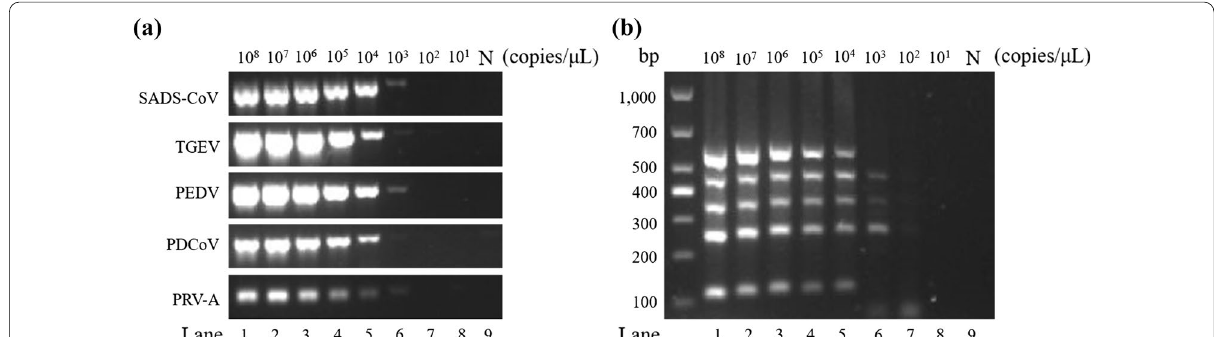
Fig. 5 Detection sensitivity of SADS-CoV, TGEV, PEDV, PDCoV, and PRV-A by the DPO system-based multiplex RT-PCR. a Standard plasmids of TGEV, PEDV, PDCoV, SADS-CoV, and PRV-A were diluted tenfold to a final concentration between 10 8 copies/μL and 10 1 copies/μL. The cDNAs were amplified with specific DPO primer sets. b The standard plasmids of each virus were incorporated after dilution and then added to a tube containing the DPO primer mixture for PCR amplification